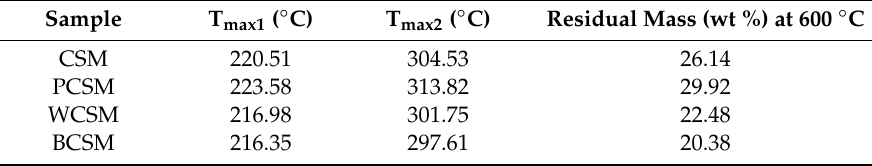
Figure 2. Thermogravimetry and derivative thermogravimetry curves of CSM, PCSM, WCSM, and BCSM adhesives. Table 2. Thermal degradation of CSM and PCSM, WCSM, and BCSM adhesives.